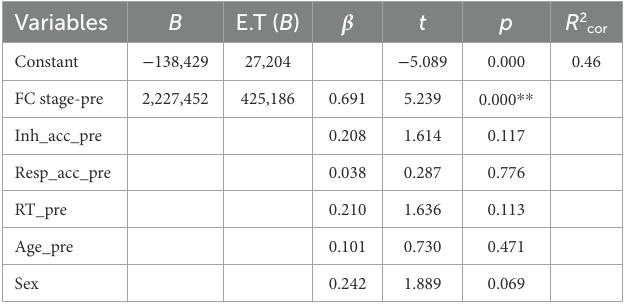
TABLE 2 Results of multivariate stepwise regression model at pre-stage. TABLE 3 Results of multivariate regression model between